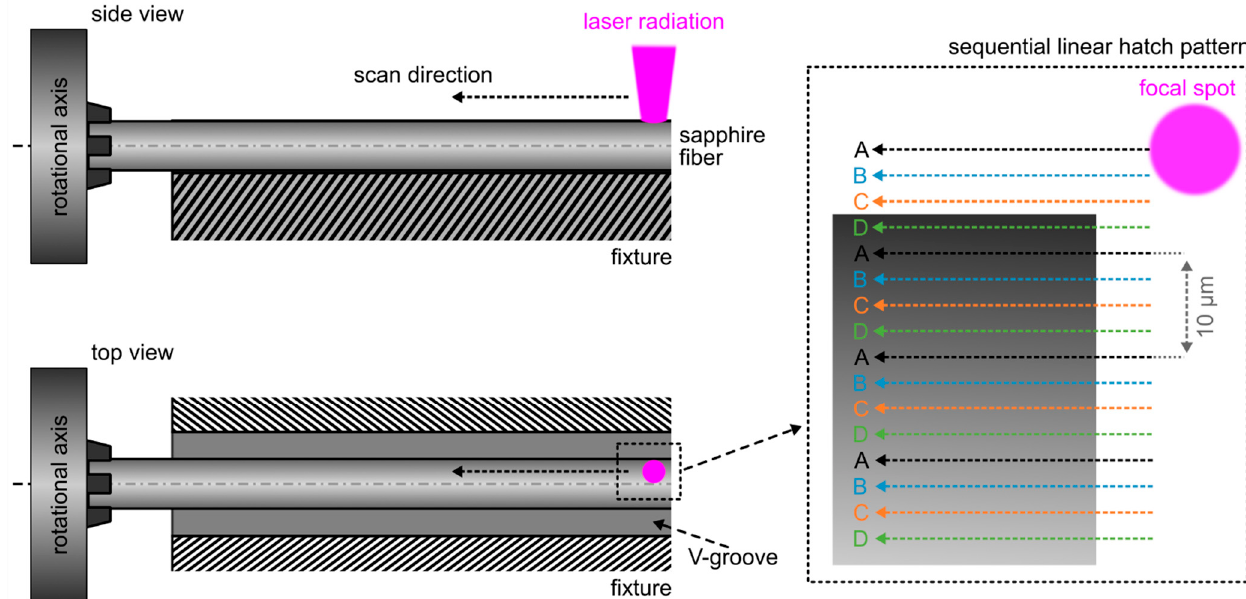
Figure 2. Femtosecond laser-based diameter reduction of sapphire rods by means of an axial scanning process combined with incremental workpiece rotation.